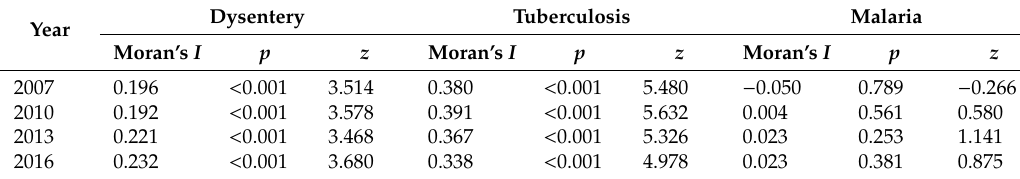
Figure 5. Geographical distribution of epidemic diseases. Table 2. Global Moran’s I of epidemic diseases incidences from 2007 to 2016.